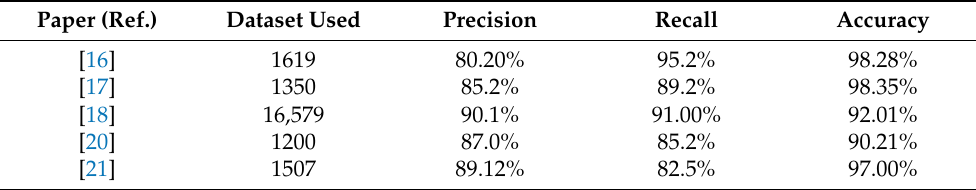
Table 1. The result of the state-of-art models. Paper